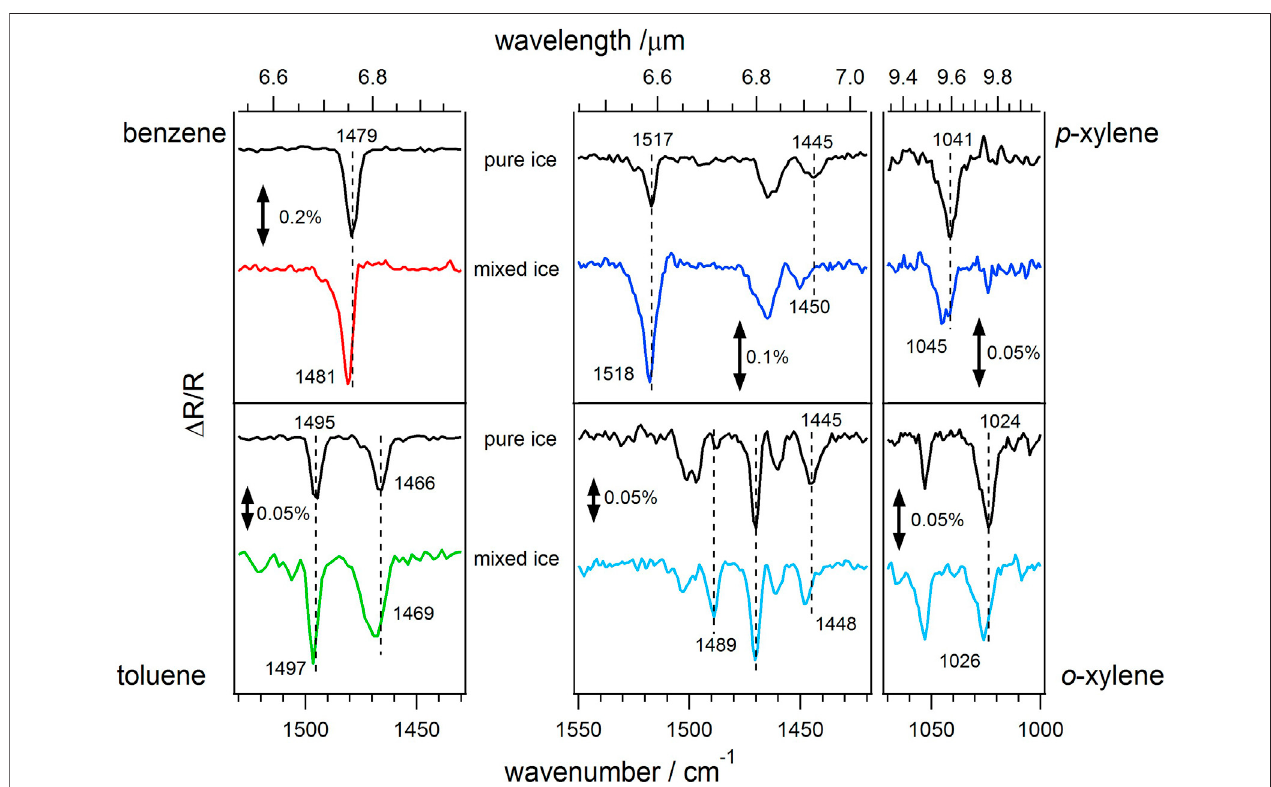
FIGURE 5 | RAIR spectra of 50 L m pure aromatic ices, and binary mixed aromatic and ASW ices, deposited between 25 and 30 K. For toluene, o -xylene and p -xylene, the spectra are for a 1:1 mixture of the aromatic molecule with ASW, 100 L m total. The benzene spectrum is a 15% mixture with ASW, 300 L m total. The left- handpanelshowsbenzeneandtoluene,topandbottomrespectively,intheregionbetween1,530and1,430 cm − 1 ,whichcontainsthearomaticC (cid:1) Cstretchingmodes. The right-hand panels show p -xylene and o -xylene, top and bottom respectively. These show the regions between 1,550 and 1,420 cm − 1 , which contains the aromatic C (cid:1) C stretching and methyl deformation modes, and the region between 1,070 and 1,000 cm − 1 which contain the methyl rocking